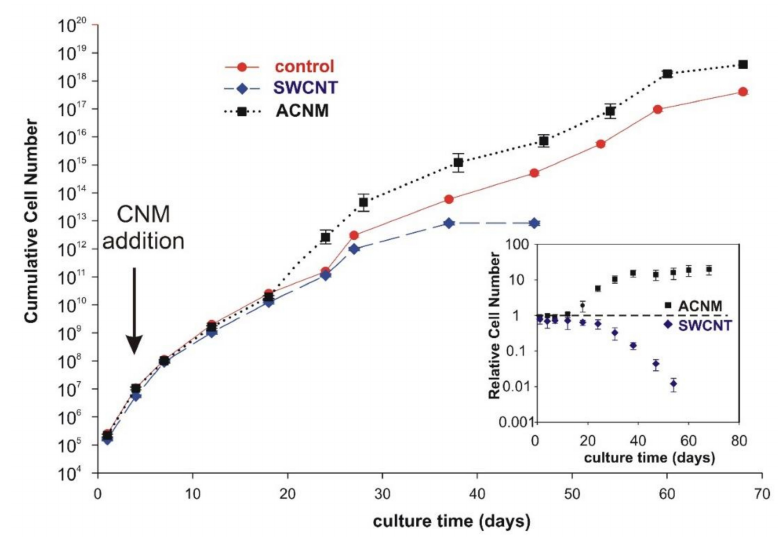
Figure 4. Growth curve of mesenchymal stem cells during long-term evaluation of tested materials. Inset presents cell number relative to control. Bars represent mean ±